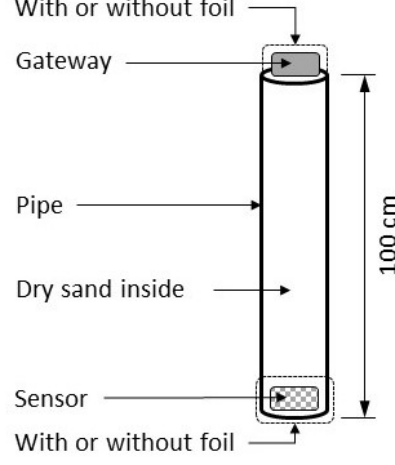
Figure 2. Experimental setup for